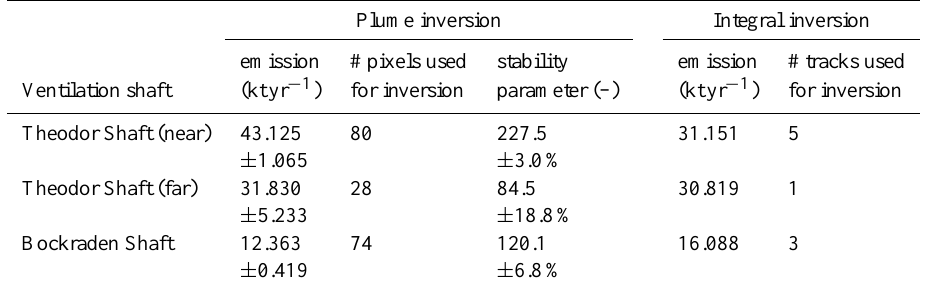
Table 2. CH 4 emission rate results in ktCH 4 yr − 1 for the coal mine ventilation shafts Theodor Shaft and Bockraden Shaft using the Gaussian plume model and the Gaussian integral inversion methods. For the Gaussian plume model, the result for the retrieved stability parameter a and the statistical errors are also given. The data from Theodor Shaft have been inverted separately for the near and far part of the plume. Plume inversion